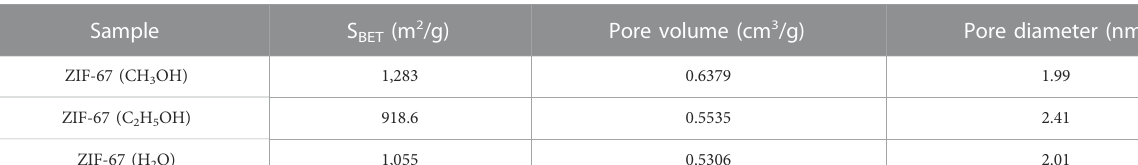
TABLE 1 Textural properties of ZIF-67.